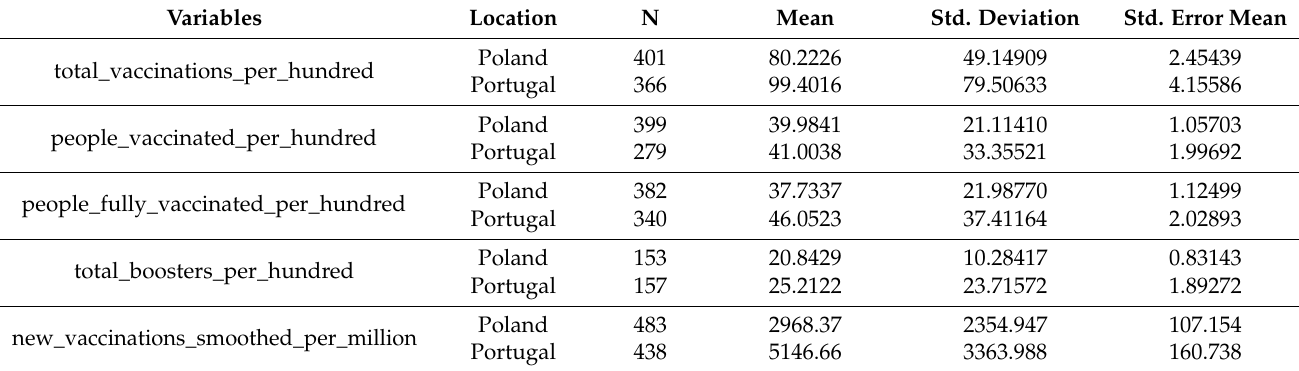
Table 2. Resume of the means of the vaccination variables concerning Portugal and Poland. Variables Location N Mean Std. Deviation Std. Error